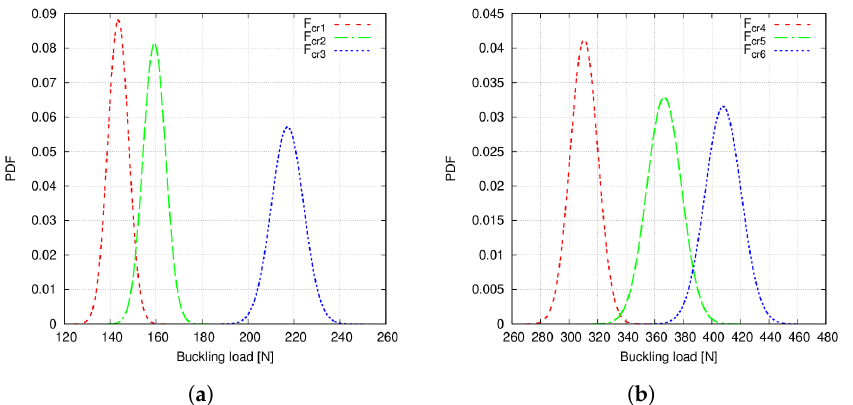
Figure 14. ( a ) Case 1 F cr 1 , F cr 2 and F cr 3 PDFs, ( b ) Case 1 F cr 4 , F cr 5 and F cr 6 PDFs. Fibre volume fraction is treated as a Gaussian random variable with mean value V f = 0.60 and standard deviation = 0.05 and no fibre waviness. σ V f